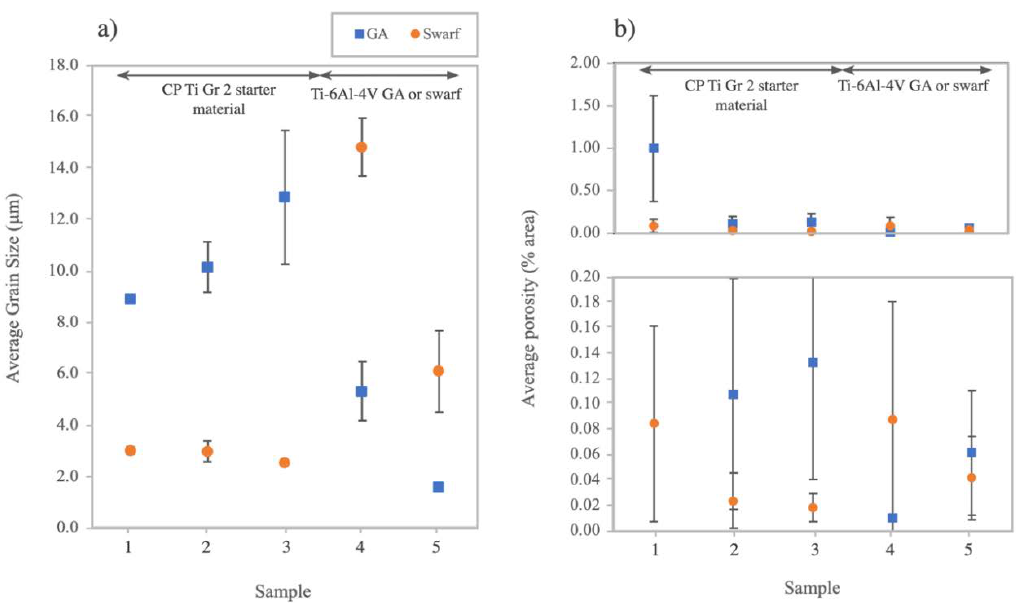
Figure 12. ( a ) Graph showing the change in the average grain size as the trial progresses. ( b ) Graph showing the change in the porosity in the material as the trial progresses.